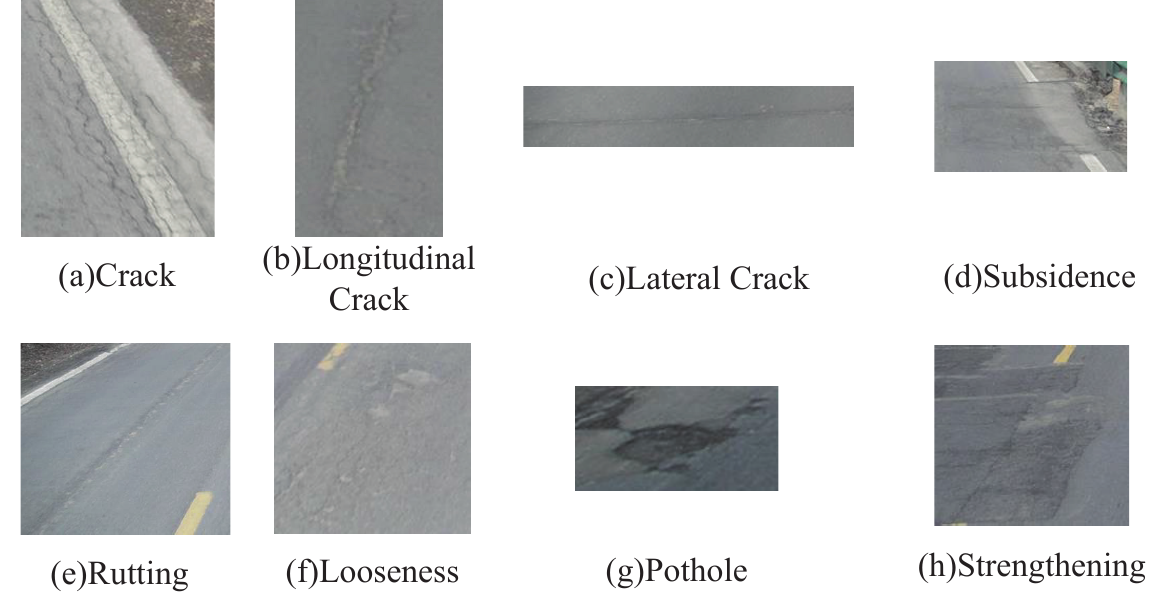
Figure 2. Schematic diagram of each